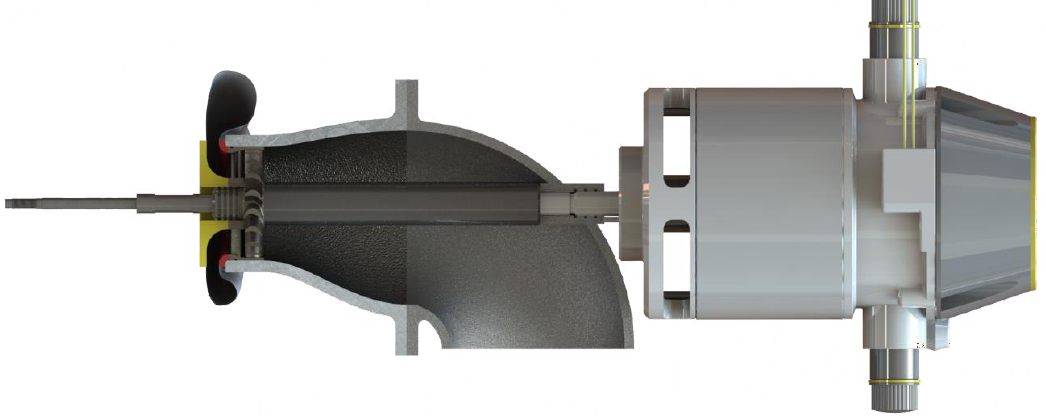
Figure 51. Concept of the turbine and Motor Generator Unit (MGU) layout.